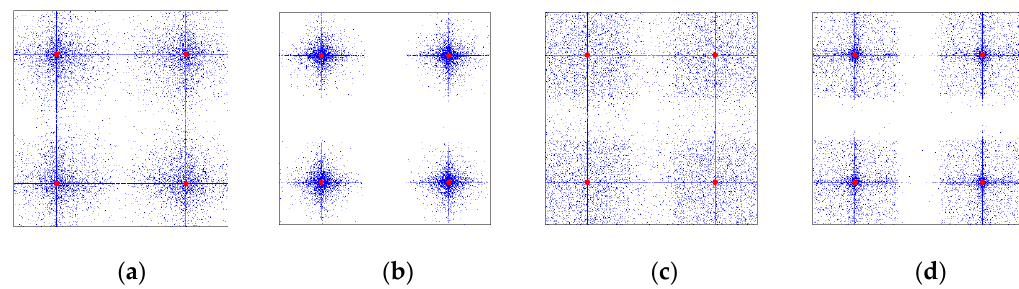
Figure 1. Impact of DI c and DI m on the distribution of offspring in the decision variable space (The red dots indicate the four parents used in SBX and PM. The blue dots denote the ten thousand offspring generated randomly from these parents with specified DI c and DI m ); ( a ) DI c = 1; DI m = 20; ( b ) DI c = 20; DI m = 20; ( c ) DI c = 1; DI m = 1; ( d ) DI c = 20; DI m = 1. Table 1. Literature survey on the applications of the Non-dominated Sorting Genetic Algorithm II (NSGA-II) to Water Distribution Systems (WDS) design problems.